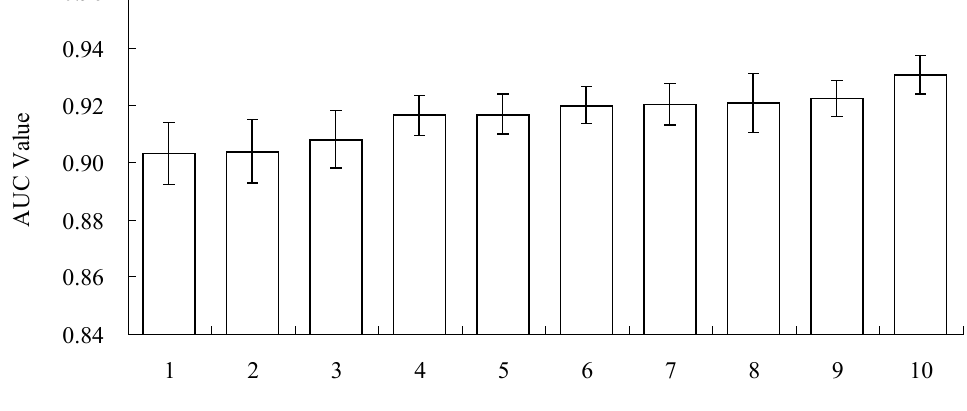
Figure 3. Areas under the receiver operating characteristic curve (AUC) values of ten-fold cross-validation models (1–10 represent the model code, ascending in order by AUC value; the mean AUC value is